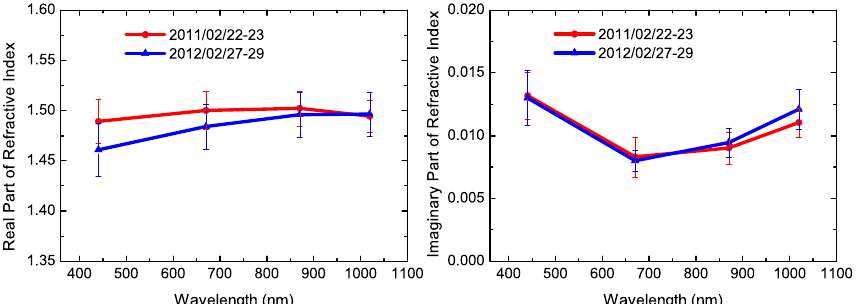
Fig. 9. The average refractive index during the haze events in 2011 and 2012 (left, the real parts; right, the imaginary parts).